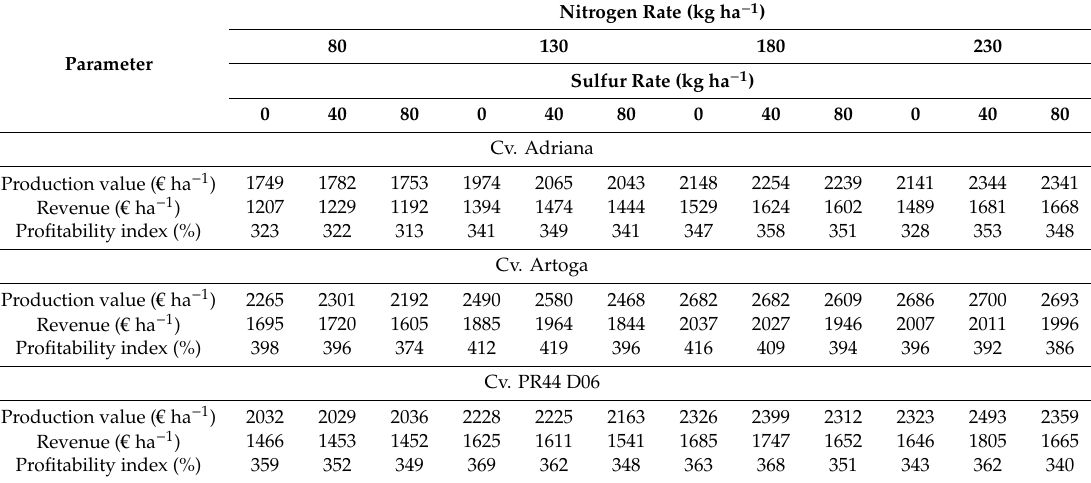
Table 10. Economic e ffi ciency of the analyzed winter oilseed rape cultivars, across years.